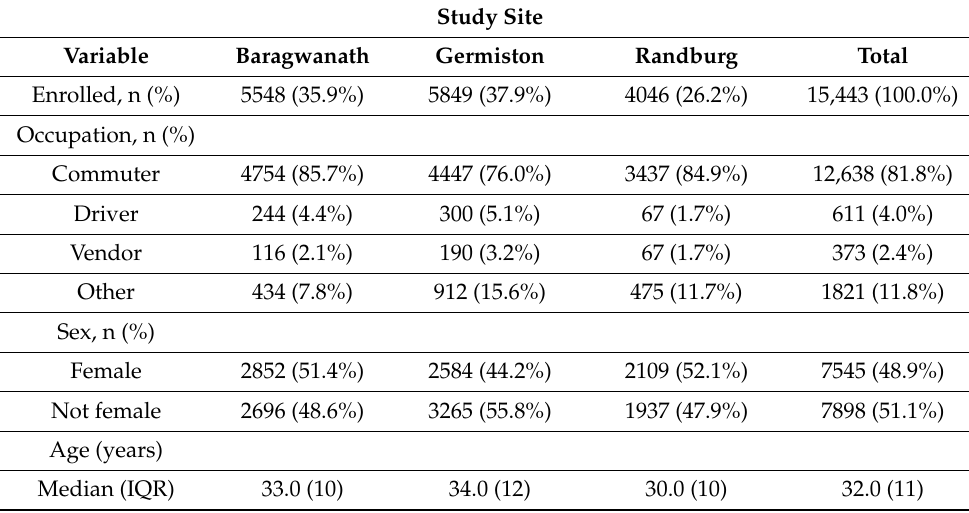
Table 1. Demographic characteristics of participants by study